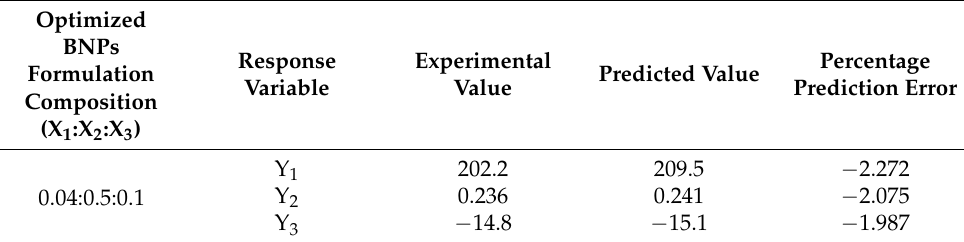
Figure 1. ( a ) Particle size and ( b ) Zeta potential of BNPs (mV). Table 2. Composition of optimum checkpoint formulations, the predicted and experimental values of response variables, and percentage prediction